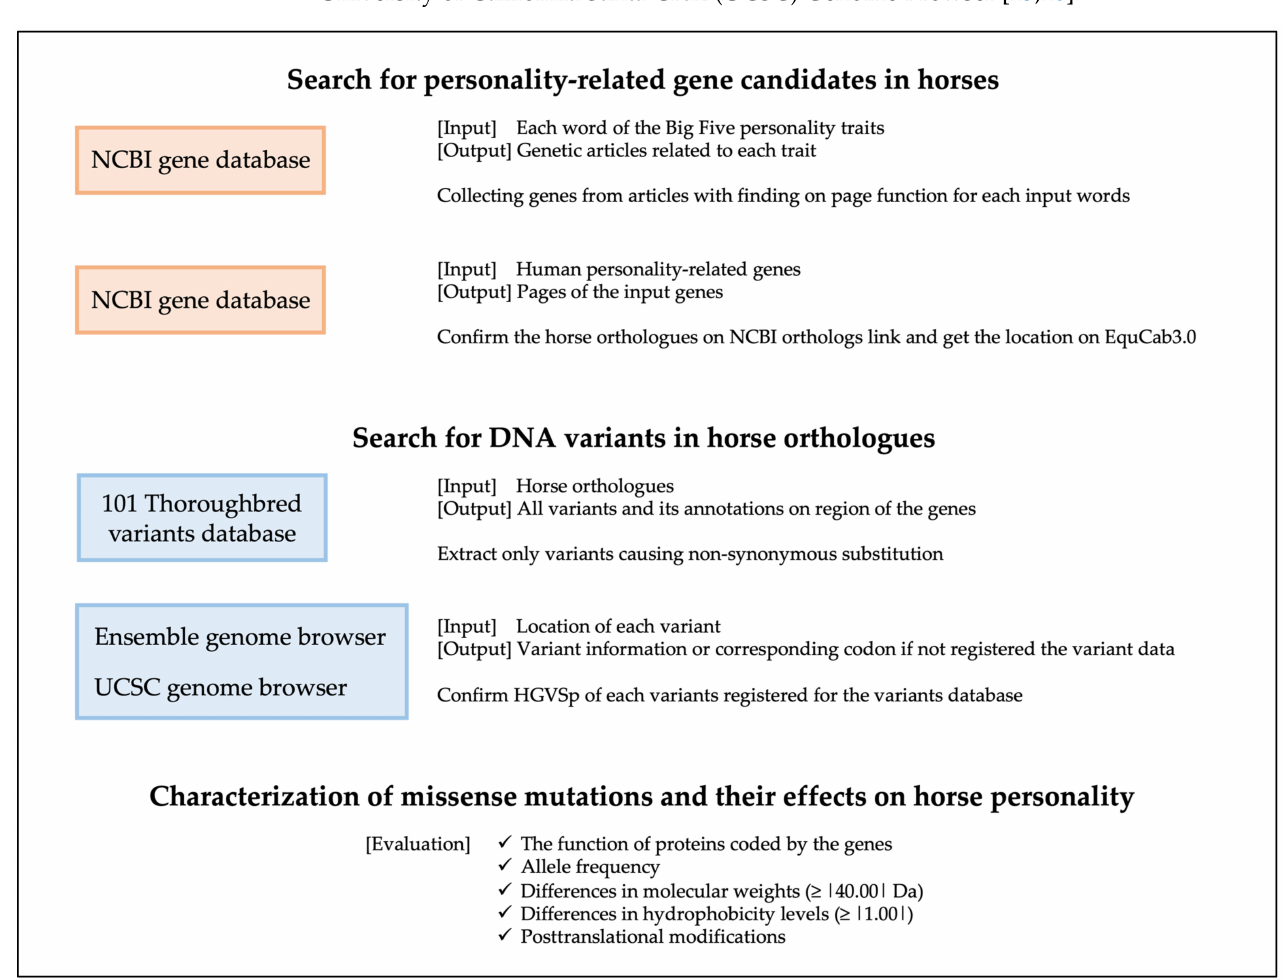
Figure 1. Methods pipeline. This shows the databases used in colored boxes, along with the inputs and outputs for each to the right side of each box. The sentences below the outputs show the objective for using each database. Finally, we list the items used to evaluate the importance of individual SNPs and their potential effect on